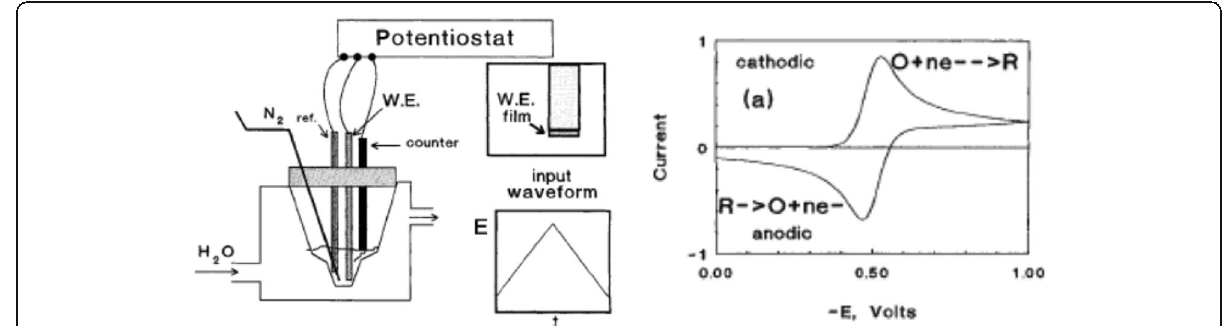
Fig. 5 (Left) A three-electrode system to measure cyclic voltammetric waveform. (Right) Ideal shape for cyclic voltammograms of a reversible diffusion-controlled reaction. (Reprinted with permission from Reference Rusling and Suib 1994). © 1994